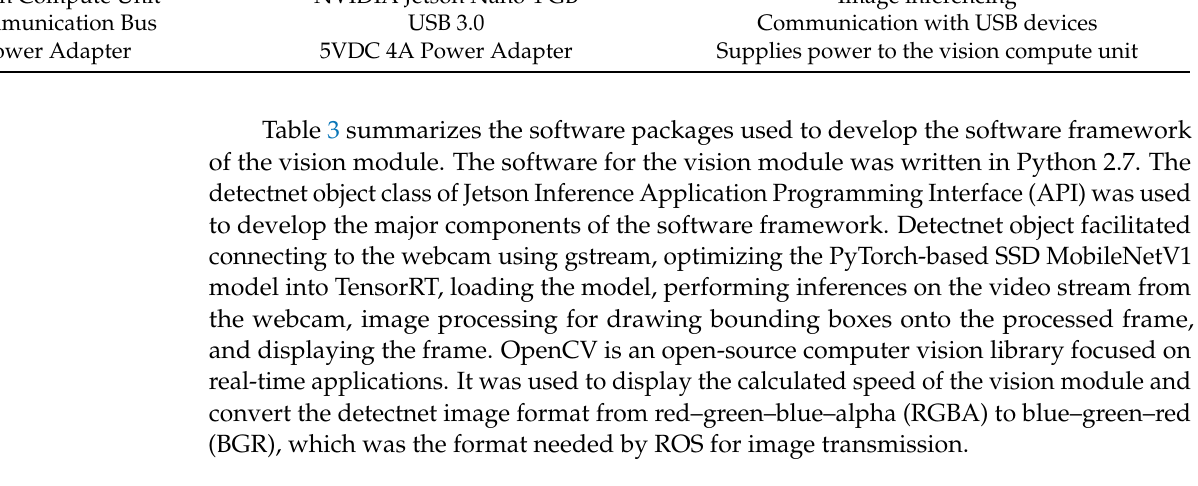
Table 3. Summary of vision module